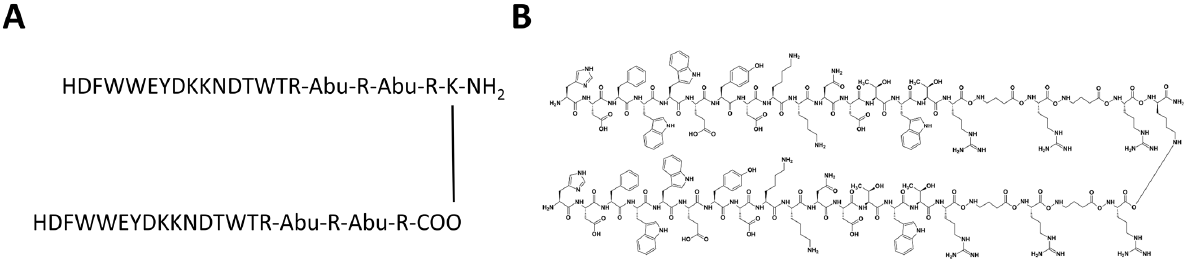
Figure 7. Amino acid single letter sequence and Natta projection of peptide construct CVRBDL-3_3. CVRBDL-3_3 was created by C-terminal attachment of two CVRBDL-3 sequences via the side chain primary amino group of a C-terminal introduced lysine. Each of the peptides carries a C-terminal [-Abu-R-Abu-R-] spacer region for increased binding flexibility and spacing of binding regions (Abu = γ -amino butyric acid). ( A ) Single letter amino acid CVRBDL-3_3 sequence. ( B ) Natta projec- tion of the CVRBDL-3_3